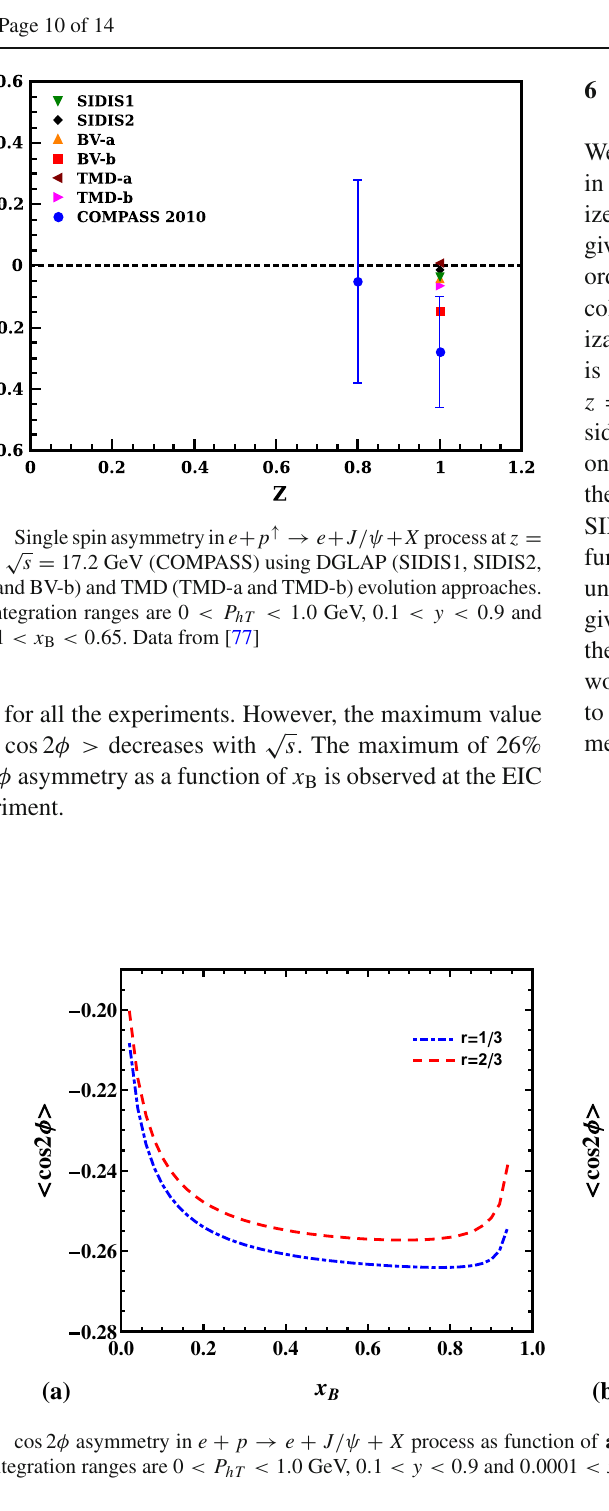
Fig. 7 cos2 φ asymmetry in e + p → e + J /ψ + X process as function of a x B (left panel) and b P hT (right panel) at The integration ranges are 0 < P hT < 1 . 0 GeV, 0 . 1 < y < 0 . 9 and 0 . 0001 < x B < 0 .